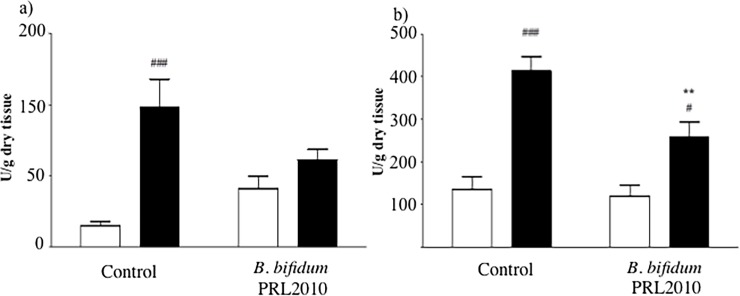
Effects of B. bifidum PRL2010 on myeloperoxidase activity in I/R mice.MPO activity, index of neutrophil infiltration, assessed in intestinal (a) and lung (b) tissue excised from SO (white columns) and I/R (black columns) mice orally administered with vehicle (Control), or supplemented with B. bifidum PRL2010 (n = 8–10 animals per group). Two-way ANOVA followed by Bonferroni’s post test: #P<0.05; ###P<0.001 vs. corresponding SO mice; **P<0.01 vs. corresponding vehicle-treated group.